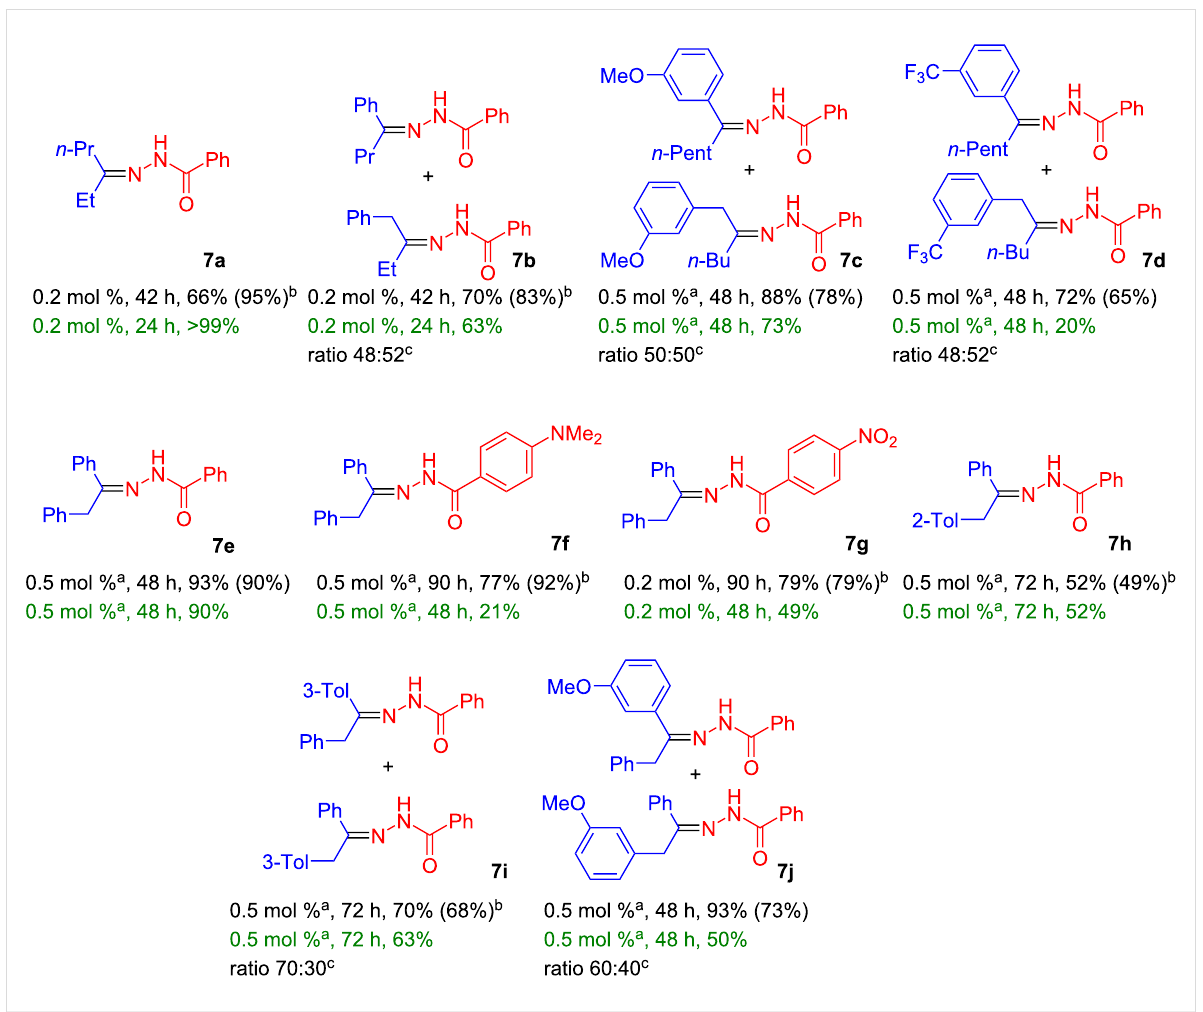
Scheme 4: Hydrohydrazidation of internal alkynes in chlorobenzene and anisole using complex 1 . Reaction temperature was 60 °C unless otherwise noted (first line solvent chlorobenzene, second line solvent anisole: catalyst loading, reaction time, conversion % (isolated yield %). a 80 °C